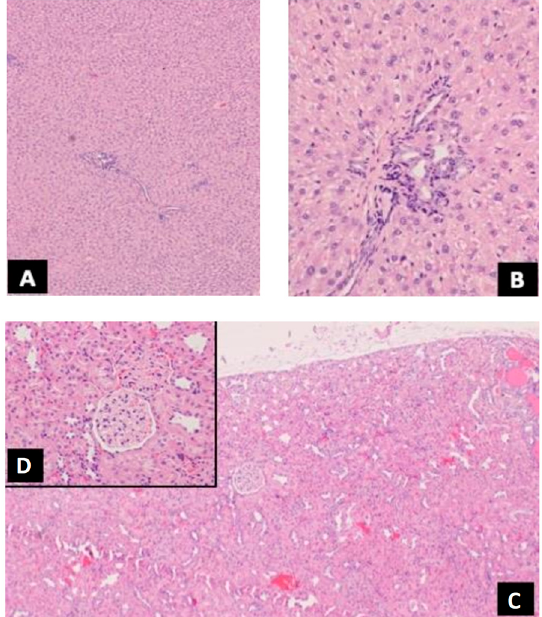
Figure 3. ( A ) Fragment of liver with very well-preserved structure; ( B ) inset: closer view of the peripheral part of liver lobule with delicate (slight) features of small droplets steatosis. Primary objective magnification: A, 4 × , B, 10 × .; ( C ) Fragment of kidney with very well-preserved structure. There are some tubules with widened lumen; ( D ) inset: closer view of glomerulus without any significant changes. Primary objective magnification: A, 4 × , B, 10 ×